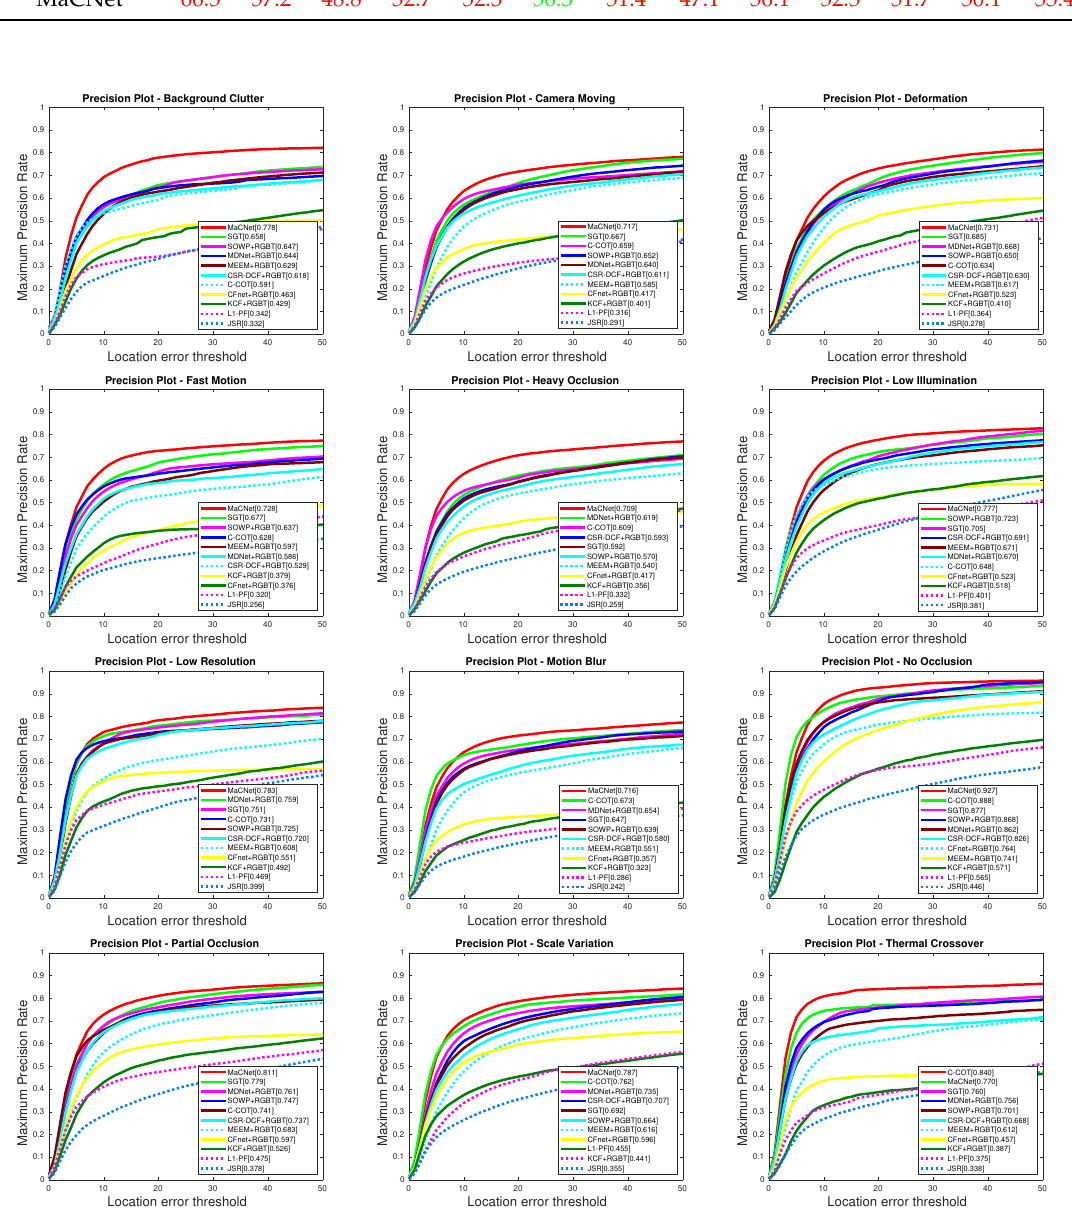
Figure 5. PR evaluation results on various attribute challenges comparing to ten state-of-the-art approaches on RGBT234